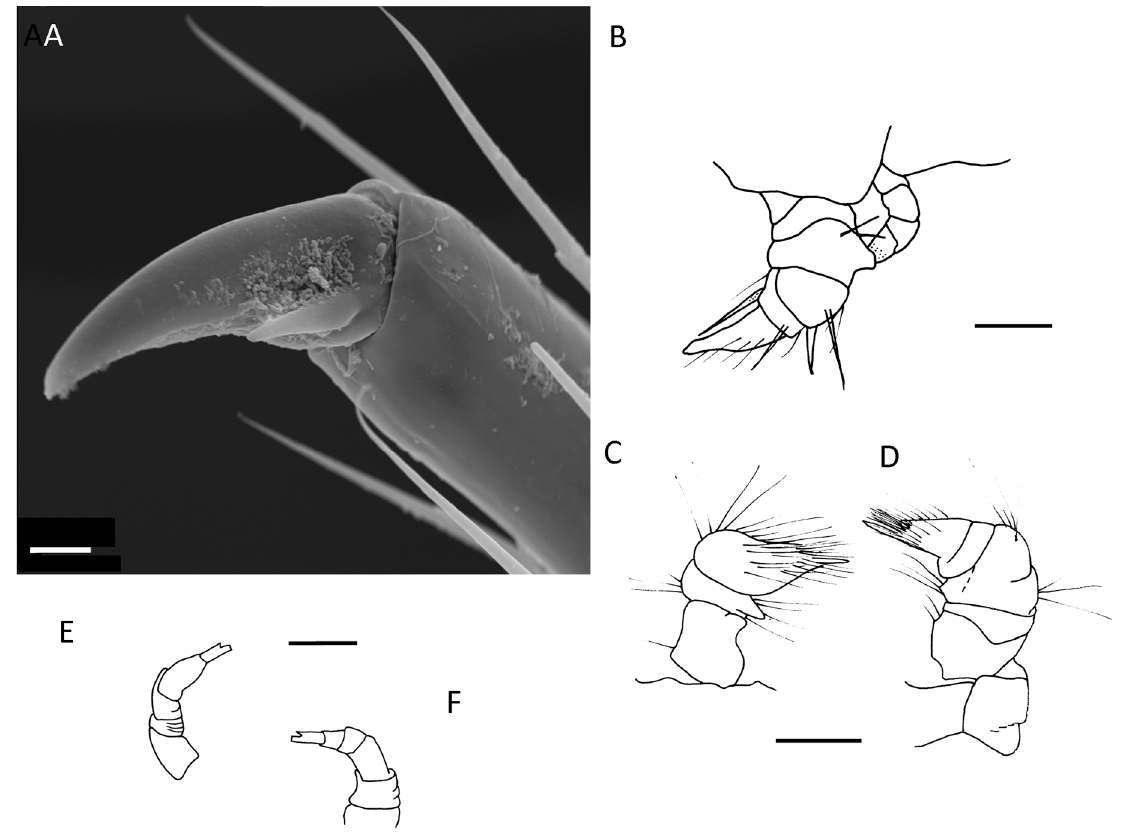
Fig. 3. Columbianum major sp. nov. A . Tarsal claw and accessory claw of midbody leg from right side of male, anterior view. B–F . gonopods of holotype male. B . In situ (apex of posterior gonopod hidden behind the anterior gonopods). C . Anterior gonopod in lateral view. D . Anterior gonopod in mesal view. E . Posterior view in lateral view (apex broken). F . Posterior gonopods in mesal view (apex broken). Scale bars = A = 0.01 mm; B–F = 0.2